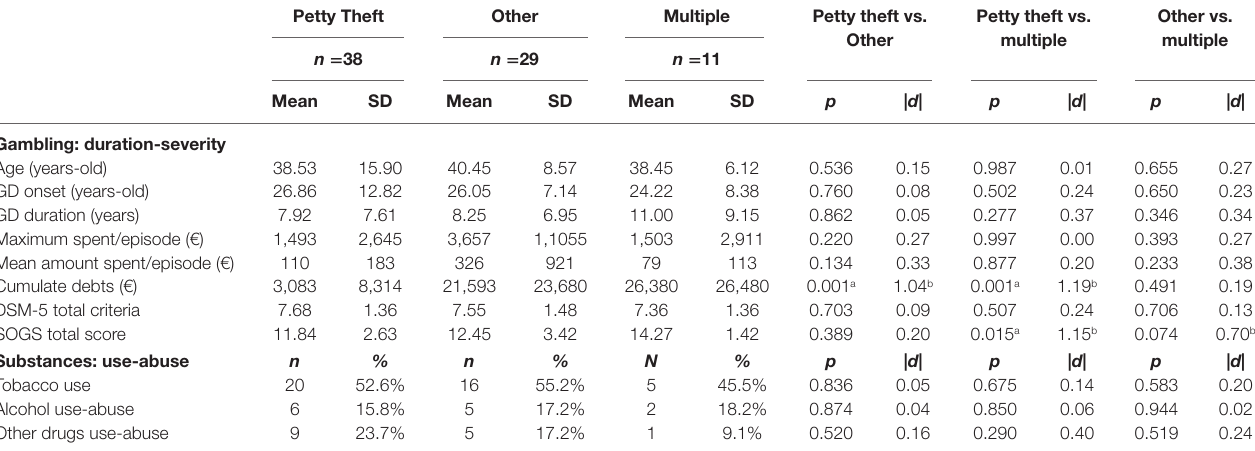
TaBle 4 | Clinical comparison for patients based on type of illegal act committed.